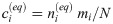
Equilibrium coverage and extension of the polymer in the presence of ligands.(Panel A): Equilibrium coverage ci(eq)=ni(eq)mi/N of a polymer as function of the tension F, assuming that the ligands bind to the polymer in a unique mode. The elastic contribution to the free energy of the naked monomers was estimated using the Marko-Siggia formula Eq (2). The equilibrium coverage was computed using both the ideal gas [Eq (18)] and the Tonks gas [Eq (20)] models. We also consider that the maximum possible coverage is 100%. (Panel B): Equilibrium extension of the covered polymer as function of the pulling force, resulting from employing the coverage of Panel A in the force-extension relation Eq (9). In this figure the values of the parameters of the polymer are of the order of those of ssDNA [24]: N = 5080, d0 = 0.57 nm, Lp = 0.715 nm, K0 = 700 pN and KBT = 4.11 pN nm, while, for the ligands, we consider two different binding modes, with parameters of the order of those of E. Coli SSB [47,59] and HmtSSB proteins [61]: m = 65 or 35, a = 5 nm and ϵb = m × 0.5 × KBT.